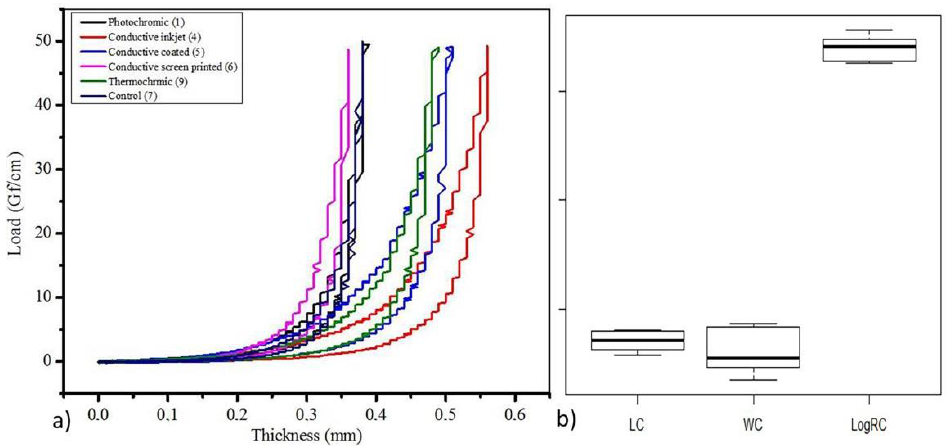
Figure 6. Compressional properties under different finishing conditions; ( a ) the amount of compression load required to compress at a certain fabric thickness and ( b ) the distributions of the compressional datasets in box plot. Fabric thickness is a constructional property measured using KES-3 which is parts that of compressional properties.